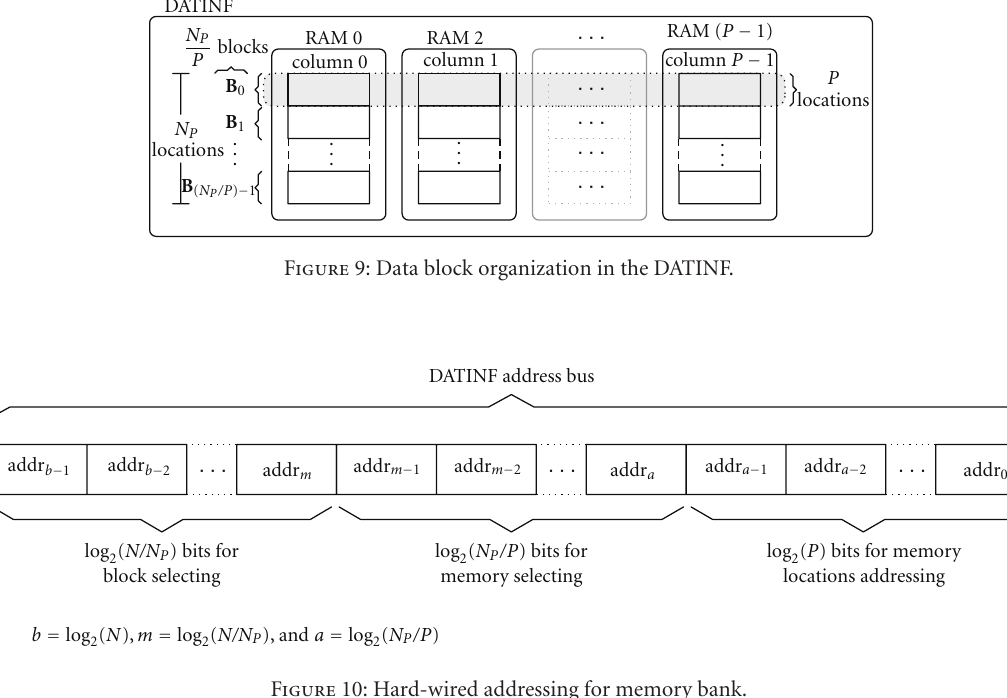
Figure 10: Hard-wired addressing for memory